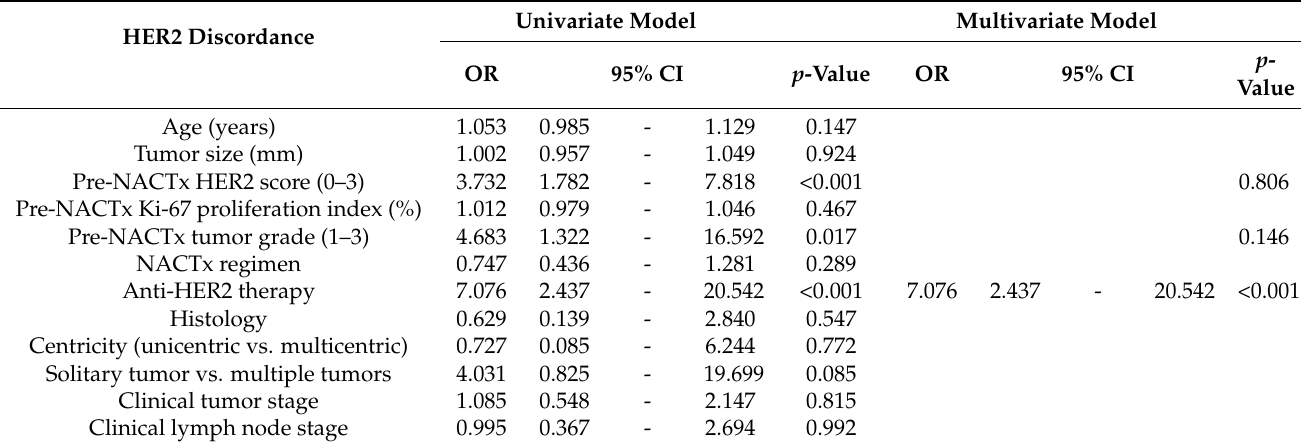
Table 5. Binary logistic regression analysis for HER2 discordance.